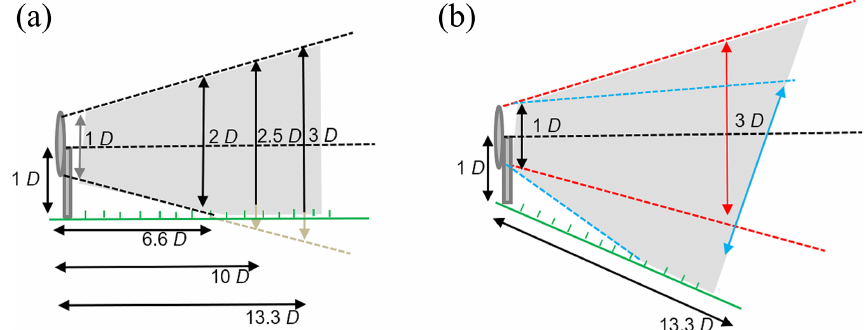
Figure 2. Schematic of wind turbine wake expansion downwind and the scanning volume needed (grey shading) in near-neutral conditions, with the horizontal wake centre line being shown by the black dashed line. (a) In flat terrain, for k = 0 . 075, the wake can be expected to impact the ground at 6–7 D downwind. (b) In complex terrain, e.g. for a turbine placed at a ridge, the wake can follow the terrain (indicated in blue) or be lofted (indicated in red); hence the scanning volume required in order to detect and characterize wakes is much